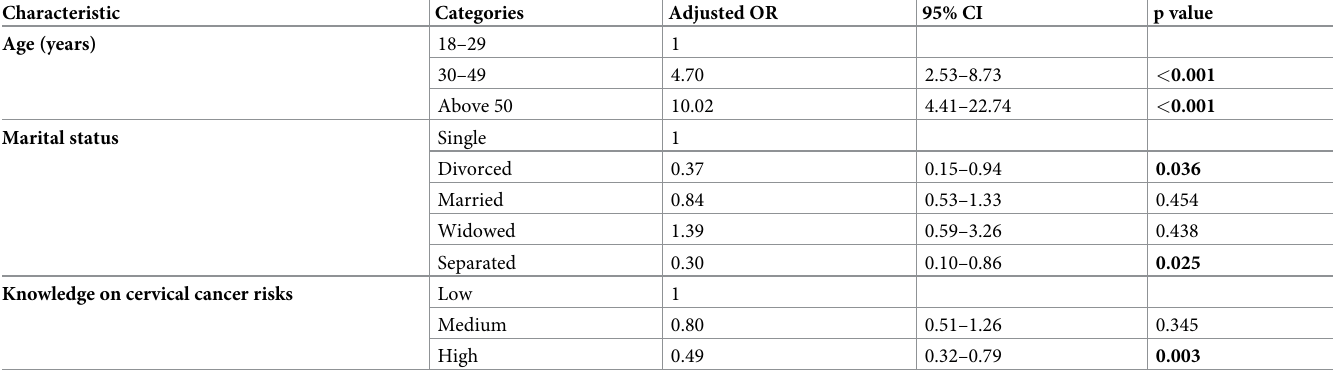
Table 3. Factors associated with cervical cancer screening in the last 10 years among black women in the past 10 years attending Pap smears in primary health care clinics in Gauteng Province, South Africa (N = 67).